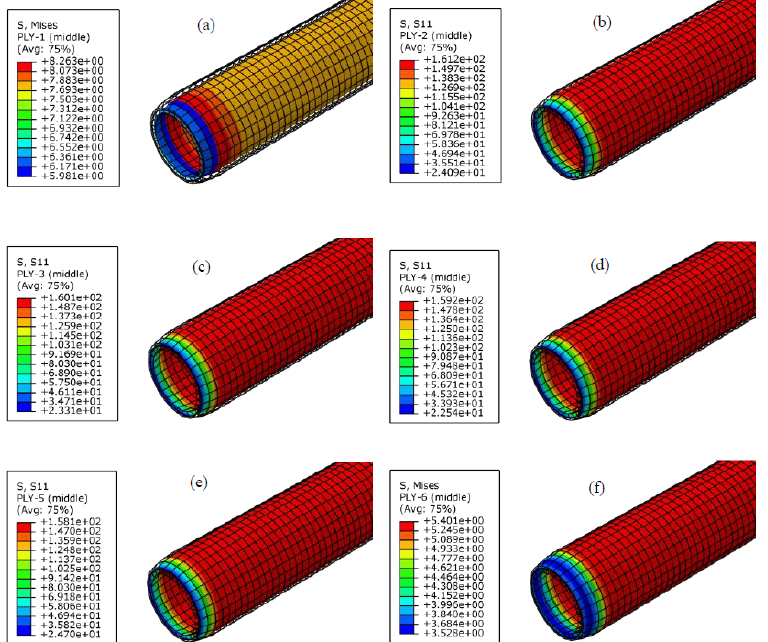
Figure 6. Stress distributions of each layer of the RTP at the inner pressure of 3.75 MPa: ( a ) liner; ( b ) the first reinforced layer; ( c ) the second reinforced layer; ( d ) the third reinforced layer; ( e ) the fourth reinforced layer; ( f ) outer cover.